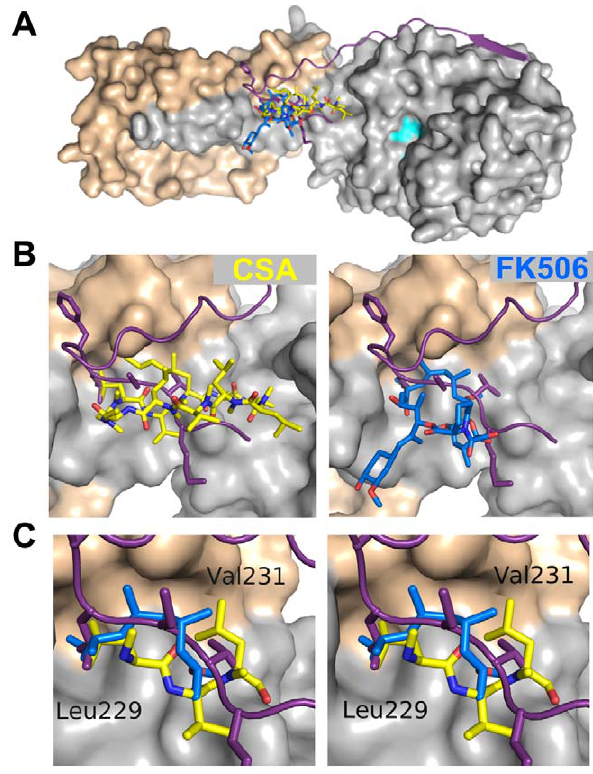
Figure 7. The immunosuppressive drugs FK506 and CSA inhibit CN by occupying the LxVP substrate recognition site. (A) Overlay of CN-bound A238L (purple), CSA (yellow), and FK506 (blue). (B, left) Overlay of A238L with CSA at the LxVP substrate binding groove. (B, right) Overlay of A238L with FK506. (C) Stereoview of the Leu229 and Val231 binding pockets in the LxVP substrate binding groove with A238L, CSA, and FK506. Some atoms of CSA and FK506 removed for